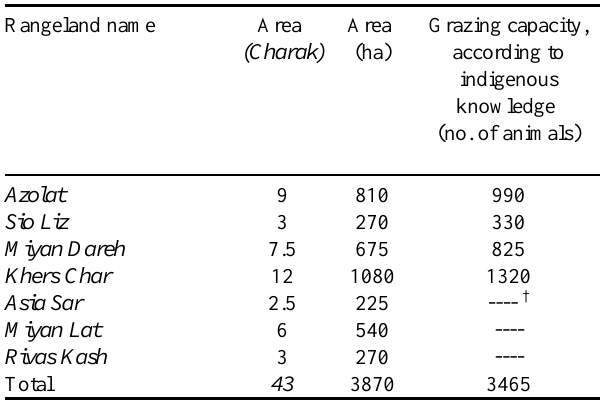
Table 4 . Estimated grazing capacity of rangelands inside the customary boundary of Nariyan village, according to indigenous ecological